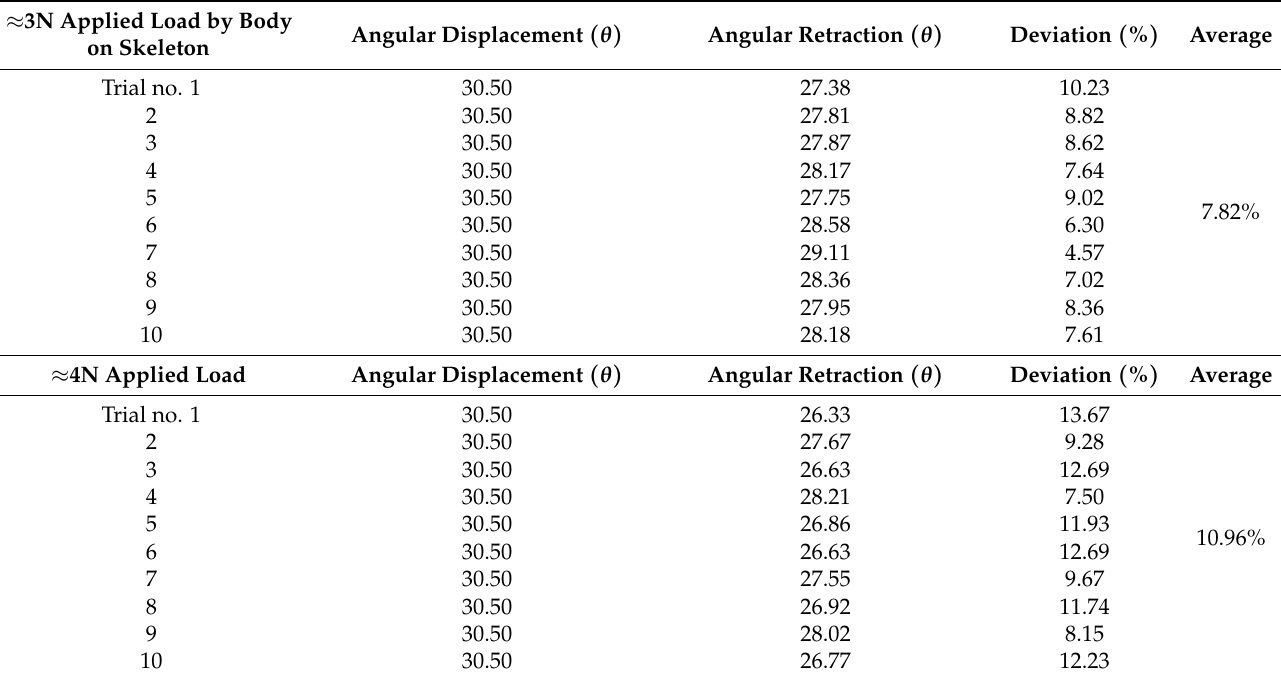
Table A3. Measured angle ( θ ) and deviation (%) with respect to 3 N–7 N applied load by body on